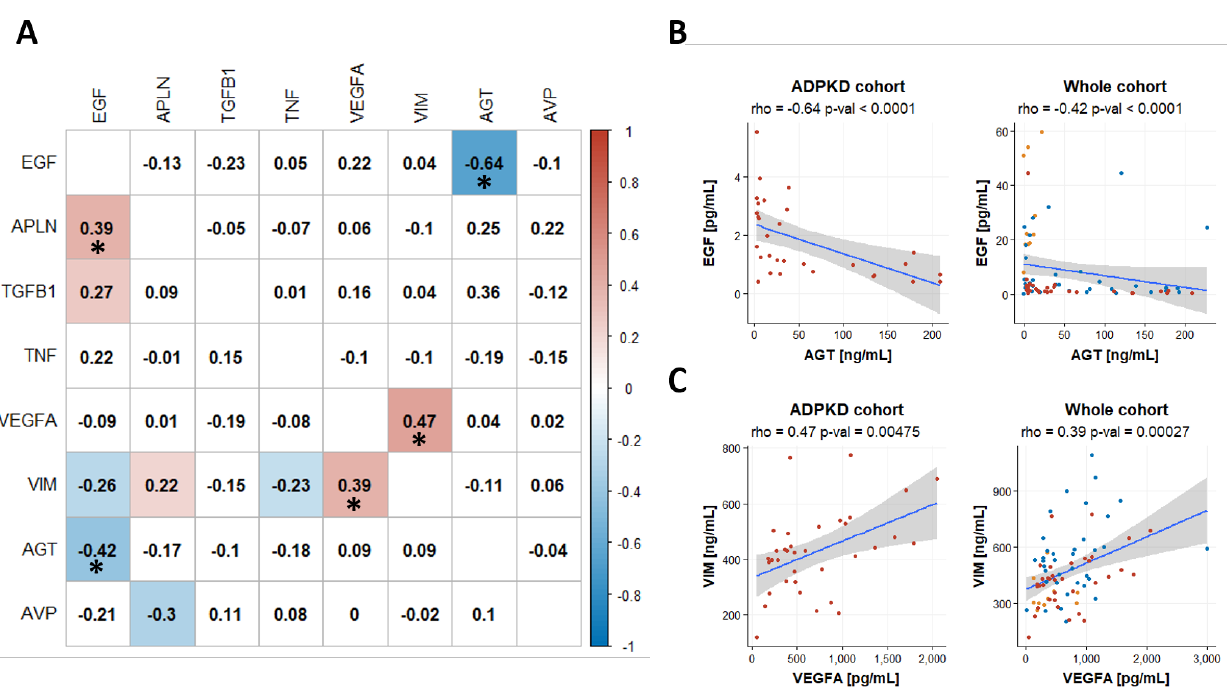
Figure 3. Panel ( A ): Correlogram displaying correlation coefficients of pairwise marker comparisons. The upper half of the matrix indicates correlations based on data from the ADPKD cohort whereas the lower half holds correlations based on data from all three cohorts of the current study. The Spearman correlation coefficient was used in all analyses. Significant correlations with p < 0.05 are highlighted with colored background. An asterisk (*) indicates correlations also being significant after Bonferroni correction for multiple testing. Panels ( B ) and ( C ): Scatterplots for urinary EGF and urinary AGT as well as serum VIM and serum VEGFA, respectively. The EGF outlier with a value of 44.49 was omitted in the scatterplot visualizations for clarity. The value was however included in the correlation analysis.